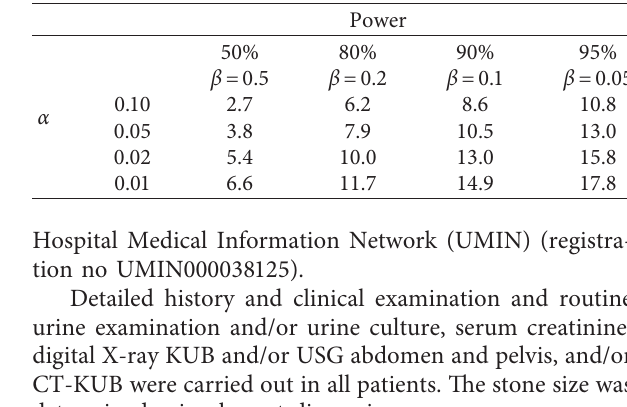
Table 1: K value for sample size